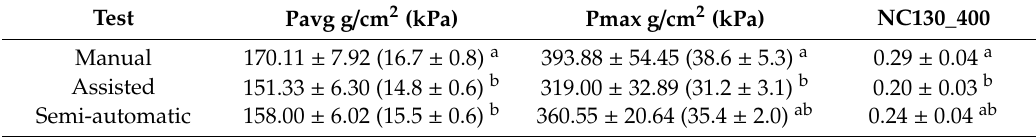
Table 2. Pressure values obtained through the barometric